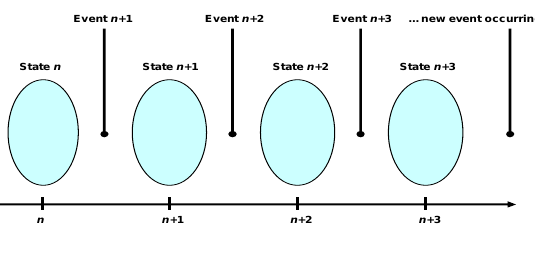
Fig. 2. Dynamic evolution of the